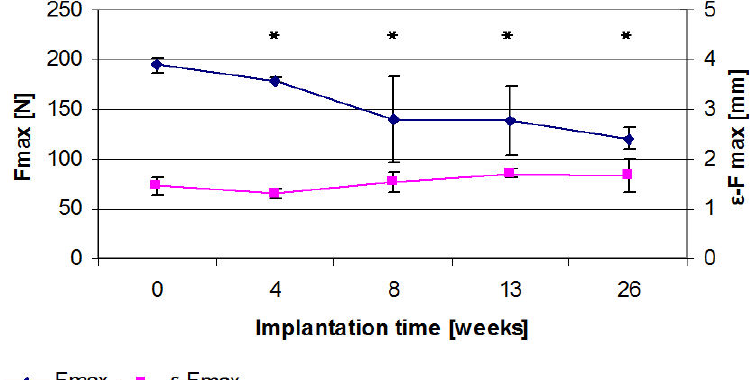
Figure 11. Three point bending tests for different implantation times after 4, 8, 13 and 26 weeks, the maximum force (Fmax) shows a distinct drop over the course of time but no significant change in elongation at fracture ( ε -Fmax) (significant changes (p ≤ 0.05) in comparison to the initial value are identified by